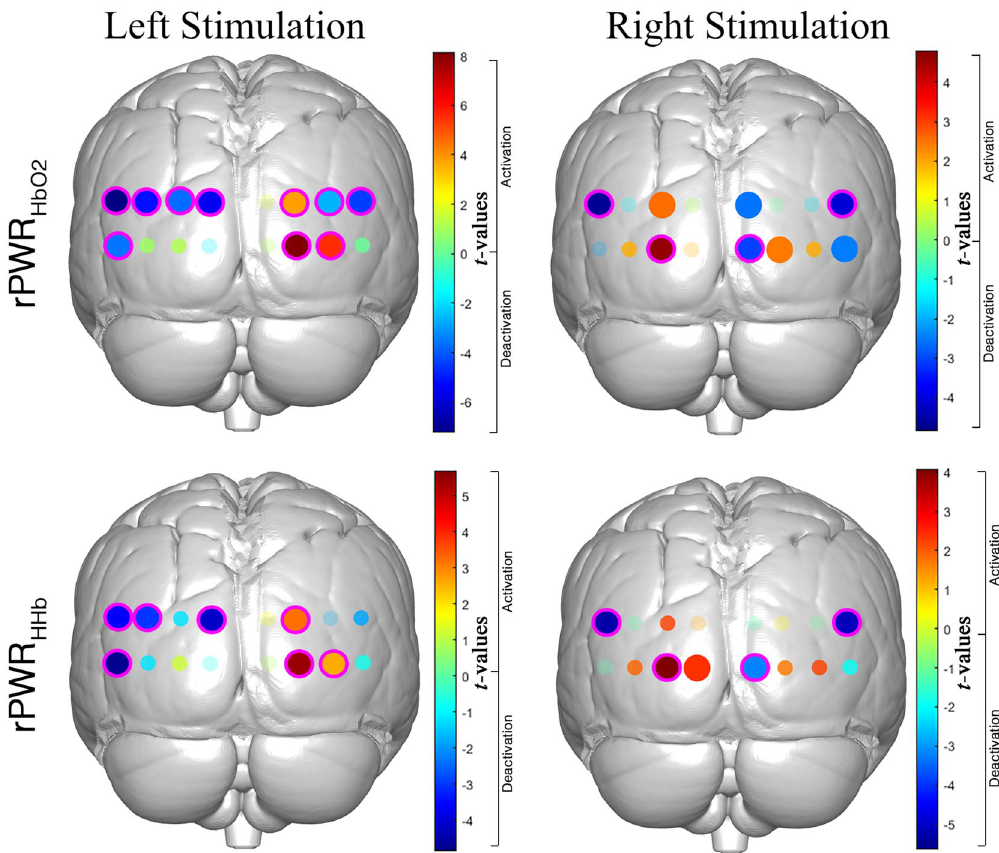
Figure 5. t -values activation maps resulting from the group-level one sample t -test against zero performed on the rPWR HbO2 (top) and rPWR HHb (bottom). t -maps are presented for the Right (right) and Left (left) stimulation conditions. Positive t -values correspond to a positive association between HbO 2 /HHb and oxCCO (i.e., channels with a greater increase in HbO 2 and oxCCO/greater decrease in HHb and increase in oxCCO) and negative t -values correspond to a negative association between HbO 2 /HHb and oxCCO (i.e., channels with a greater decrease in HbO 2 and oxCCO/greater increase in HHb and decrease in oxCCO). Small shaded circles represent non-significant channels (p > 0.05), solid big circles represent significant channels (p < 0.05), and magenta circles indicate the significant channels (p < 0.05) surviving the FDR